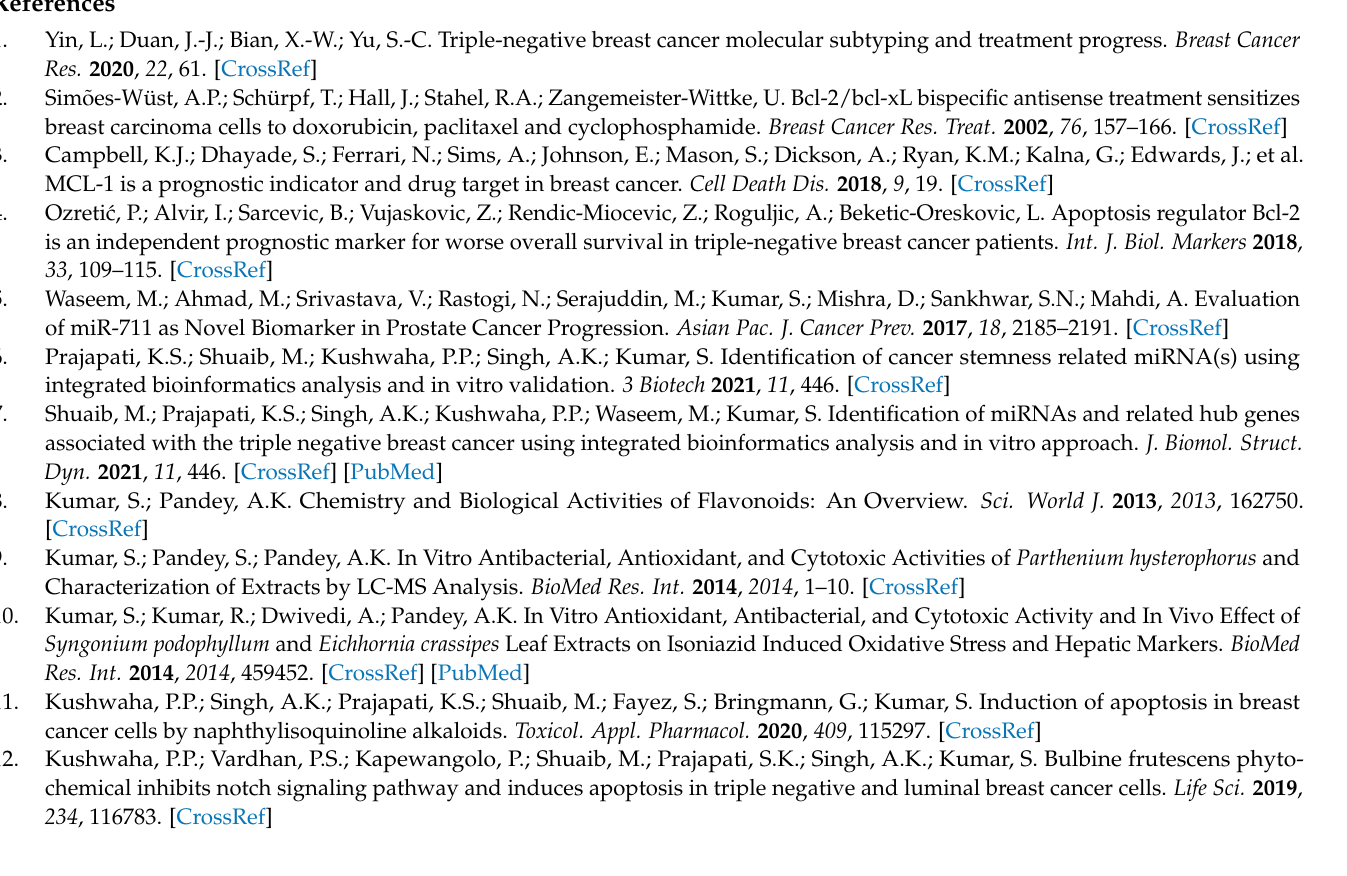
sequences; Table S2: List of mRNA primers and their sequences; Table S3: List of differentially expressed miRNAs among the test groups; Table S4: The Log2FC and p values of the top five up and down-expressed miRNAs. Table S5: List of miRNA target genes for significant differentially expressed